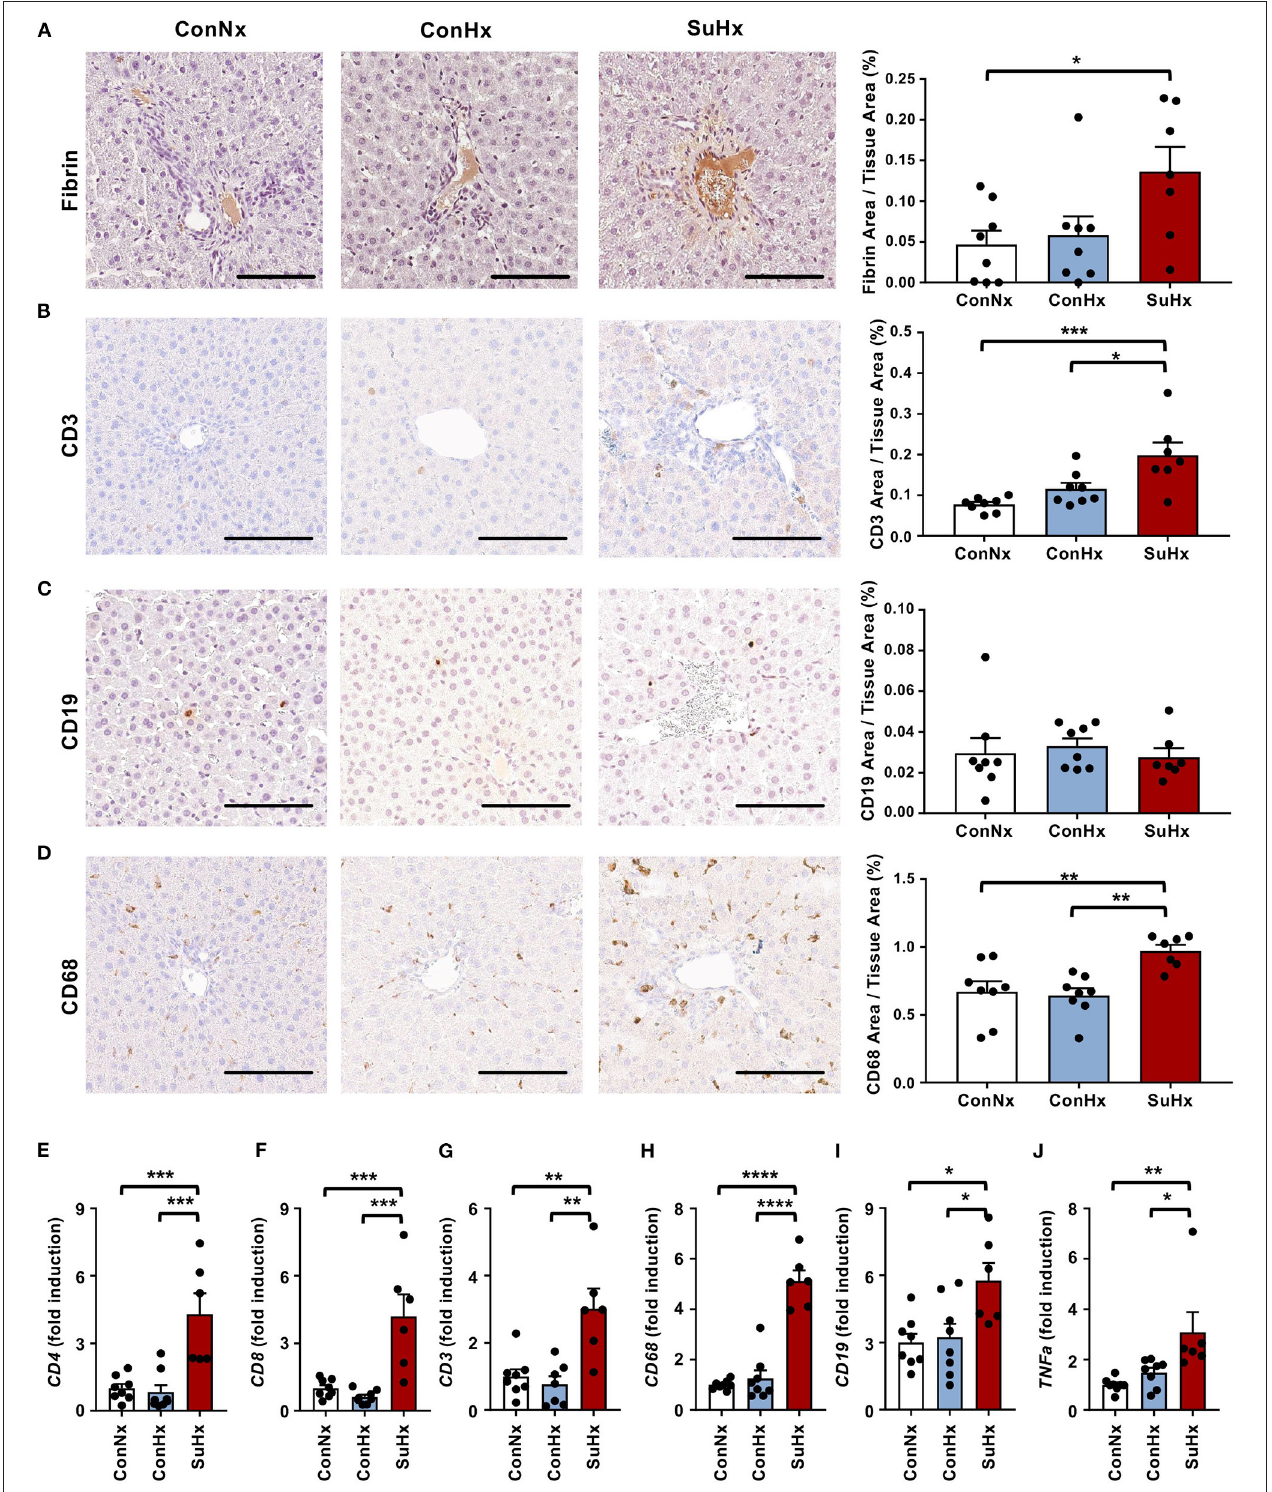
FIGURE 4 | PAH livers show increased coagulation and liver immune cell infiltration is mainly comprised of T-cells and macrophages. (A–D) Representative pictures and quantification of IHC for coagulation marker fibrin, as well as immune cell markers of T-cells (CD3), B-cells (CD19) and macrophages (CD68). (E–J) Relative expression of immune cell markers CD4, CD8, CD3, CD68, CD19 and TNFa determined by qPCR from whole liver. Means ± SEM, ConNx n = 8, ConHx n = 8, SuHx n = 7, ANOVA-Bonferroni post-hoc test, * p < 0.05, ** p < 0.01, *** p < 0.001, **** p < 0.0001, Scale bars: 100 µ m.